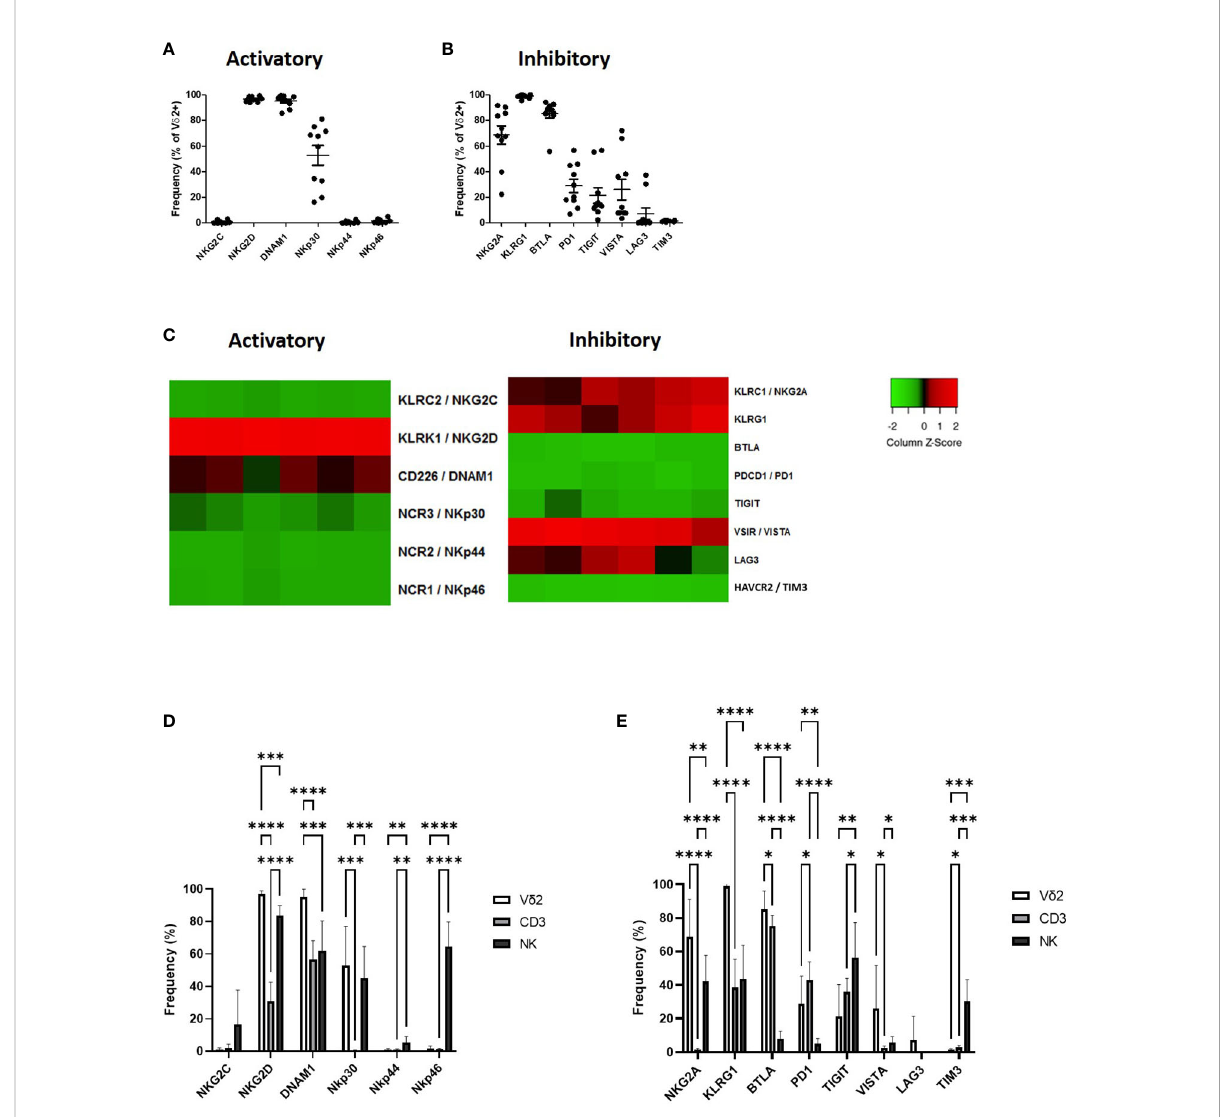
FIGURE 1 Expression of NK associated activatory receptors (A) and inhibitory checkpoint receptors (B) was determined in V g 9V d 2+ cells in PBMCs from healthy donors using fl ow cytometry. Heat maps showing the expression of NK associated activatory and inhibitory receptors in V g 9V d 2+ cells from 6 donors using RNAseq (C) . Expression of NK associated activatory receptors (D) and inhibitory checkpoint receptors (E) in V g 9V d 2+ cells was compared to CD3+ T-cells and CD56+ NK cells. N=10. *p<0.05, **p<0.005, ***p<0.0005, ****p<0.0001, non-parametric analysis of variance with Tukey ’ s post hoc for multiple pairwise